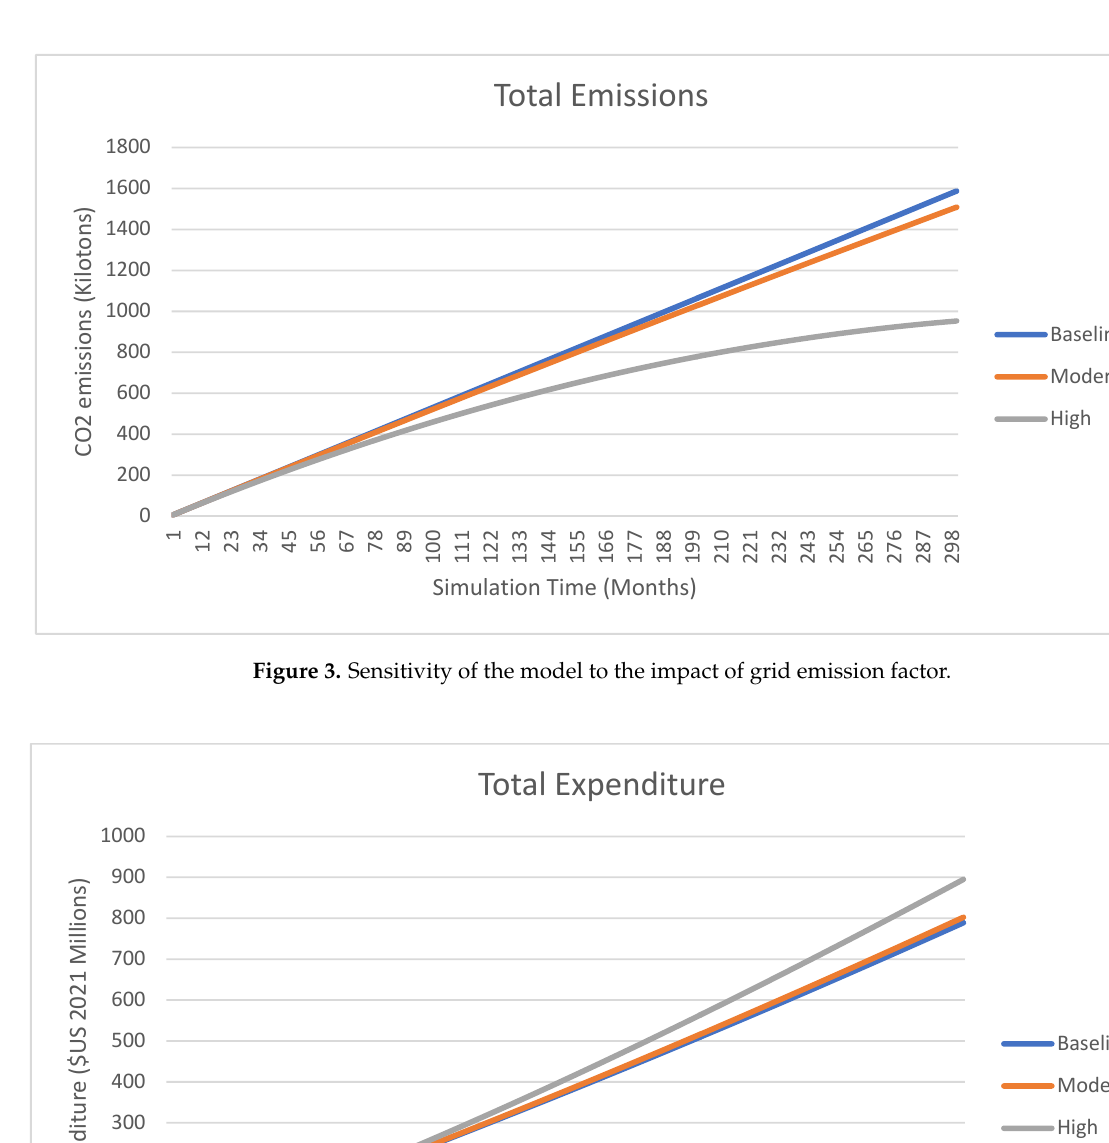
Figure 5. Cumulative emissions through electricity consumption for UAE and DE under the base scenario.